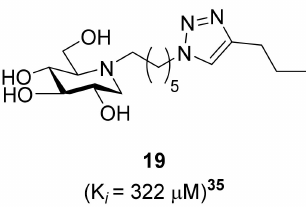
Figure 4. DNJ derivative chosen as the monovalent reference to evaluate the relative potency of the AuGNPs synthesized in this